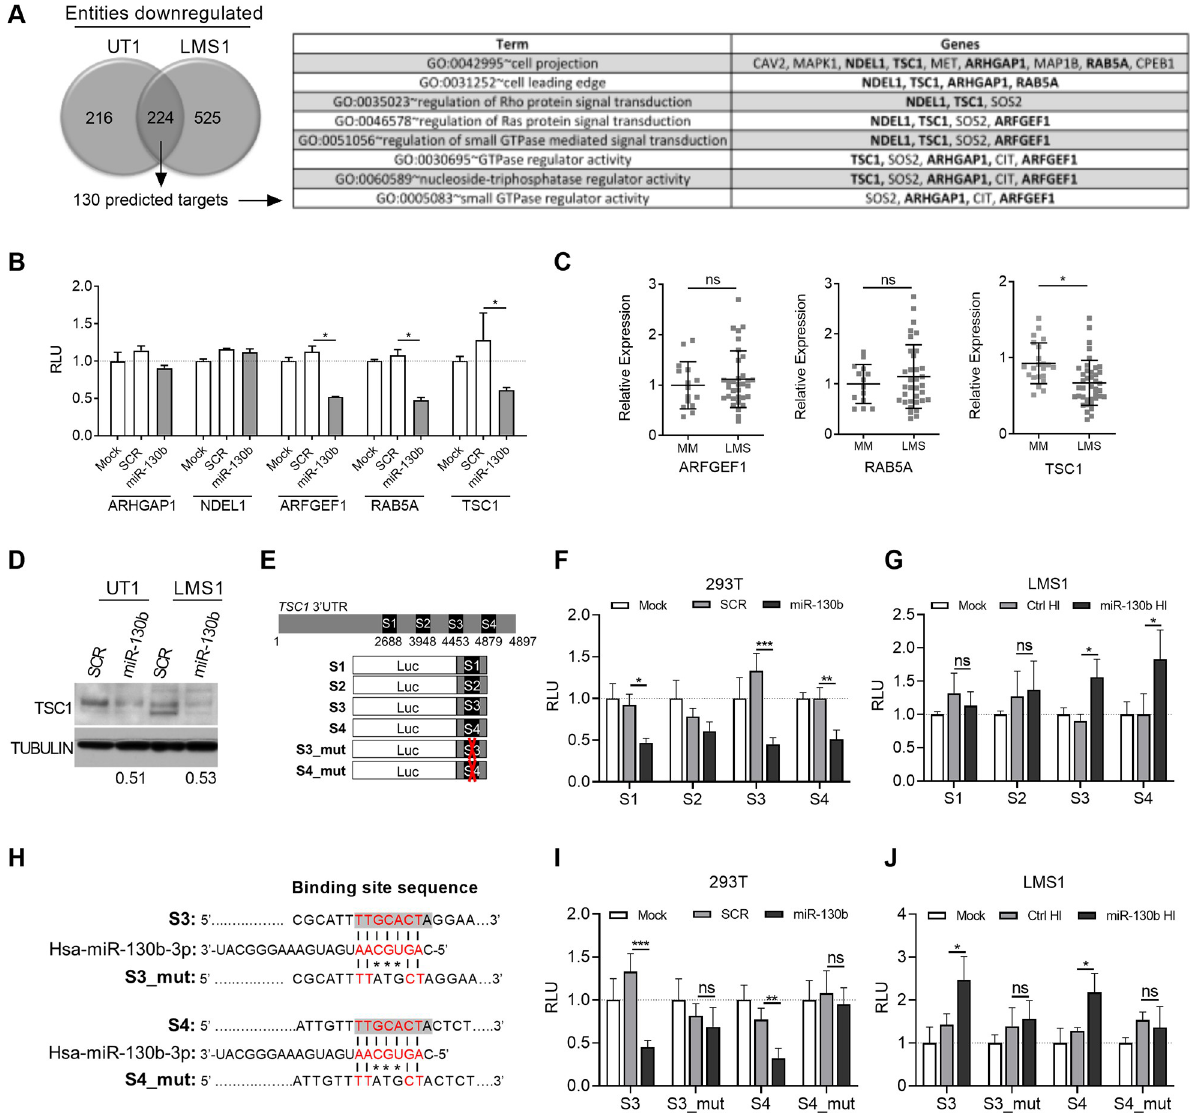
Fig 3. TSC1 is a direct target of miR-130b and downregulated in LMS. (A) Number of transcripts showing significant downregulation (fold change: 1.33; P < 0.05) following gene array profiling of SK-LMS1 and SK-UT1 cell lines transfected with miR-130b or mimic controls ( left ). Profiling was performed in triplicate for each cell line. Gene ontology analysis was performed on shared downregulated genes identified as putative direct targets by target site prediction (130 total), revealing enrichment of pathways associated with cell motility and Rho GTPase signaling ( right ). (B) Luciferase-3’UTR reporter assay for validation of 5 candidate miR-130b targets selected from (A). Values represent relative luciferase units (RLU) in 293T cells following mock (no mimic), SCR or miR-130b mimic transfection (n = 4). Values are normalized to the mock control for each luciferase- 3’UTR construct. Statistical analyses were performed by two-tailed students t-test; � P < 0.05 vs SCR controls. (C) Relative mRNA expression of validated targets, from (B), using a previously published dataset [27]. Note that only TSC1 shows significant downregulation compared to normal MM. Statistical analyses were performed by two-tailed students t-test; � P < 0.05 vs MM. (D) TSC1 Western blot in UT1 and LMS1 cell lines 48 h after miR-130b or SCR control transfection. Numbers indicate relative TSC1 band intensities of miR-130b-transfected groups versus SCR controls after normalizing using tubulin levels. (E) S1-S4 luciferase reporter constructs for identification of functional miR-130b sites in the TSC1 3’UTR. (F) Relative luciferase activities of S1-S4 constructs in 293T cells following mock, SCR or miR-130b transfection ( as in panel B ) (n = 4). (G) Relative luciferase activities of S1-S4 constructs in LMS1 cells following mock, ctrl HI or miR-130b HI transfection (n = 4). (H) MiR-130b binding site sequences in wild type (S3 and S4) and mutant (S3_mut and S4_mut) constructs. Shaded text indicates predicted MiR-130b binding sites within the wild type sequences. Red text indicates seed region. (I) Relative luciferase activities of wild type and mutant S3 and S4 constructs in 293T cells following mock, SCR or miR-130b transfection (n = 4). (J) Relative luciferase activities of wild type and mutant S3 and S4 constructs in LMS1 cells following mock, ctrl HI or miR-130b HI transfection (n = 4). Statistical analyses ( F , G , I , J ) were performed by two-tailed students t-test; � P < 0.05, �� P < 0.005, ��� P < 0.001 vs SCR or Ctrl HI. Values are normalized to the mock controls for each luciferase